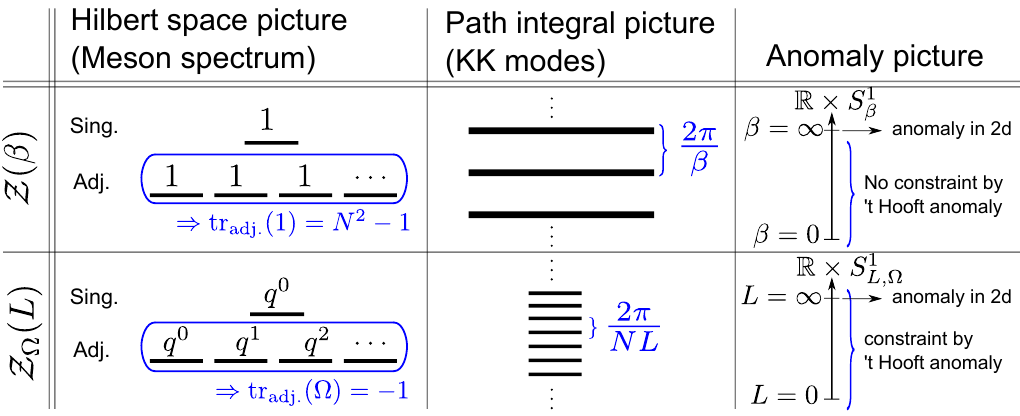
Figure 1 . Schematic illustration of the advantages of the symmetry-twisted partition function Z (cid:10) ( L ) in comparison with the thermal partition function Z ( (cid:12) ). In the left column, we count the degrees of freedom of mesons. Mesons give a large, O ( N 2 ) contribution to Z ( (cid:12) ) since they are in the adjoint representation of the SU( N ) = Z N symmetry, while Z (cid:10) ( L ) is a(cid:11)ected only by O (1). In the middle column, it is explained by the Kaluza-Klein (KK) or Matsubara decomposition of the (cid:12)elds, and the KK modes in Z (cid:10) ( L ) are much denser than those of Z ( (cid:12) ), due to the (cid:13)avor-momentum transmutation. In the right column, we explain its consequence for the ’t Hooft anomaly of the theory, and the ’t Hooft anomaly in 2 dimensions persists in Z (cid:10) ( L ) for any L , while it survives in Z ( (cid:12) ) only for (cid:12) ! 1